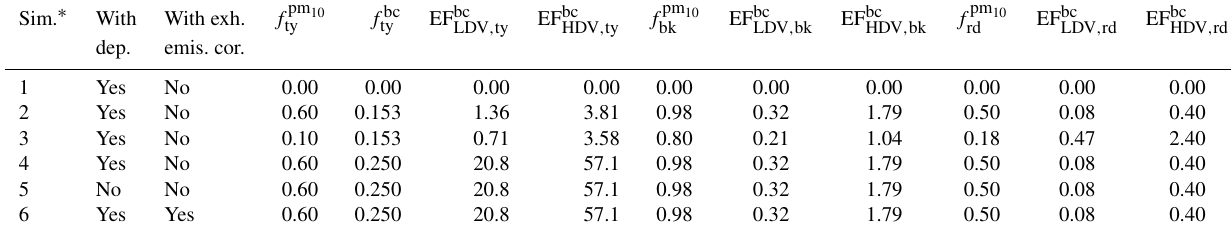
Table 1. List of the simulations performed, with the configuration options (with or without deposition, and with or without exhaust emission pm 10 correction), the PM 10 fraction ( f s ) adopted in each wear emission source (tire wear indicated by ty, brake wear indicated by bk, and road wear indicated by rd), the BC fraction adopted in tire wear emissions ( f bc ty ), and the corresponding BC emission factors for each wear emission source and vehicle type HDV and LDV (EF bc v,s ) (in milligrams per vehicle